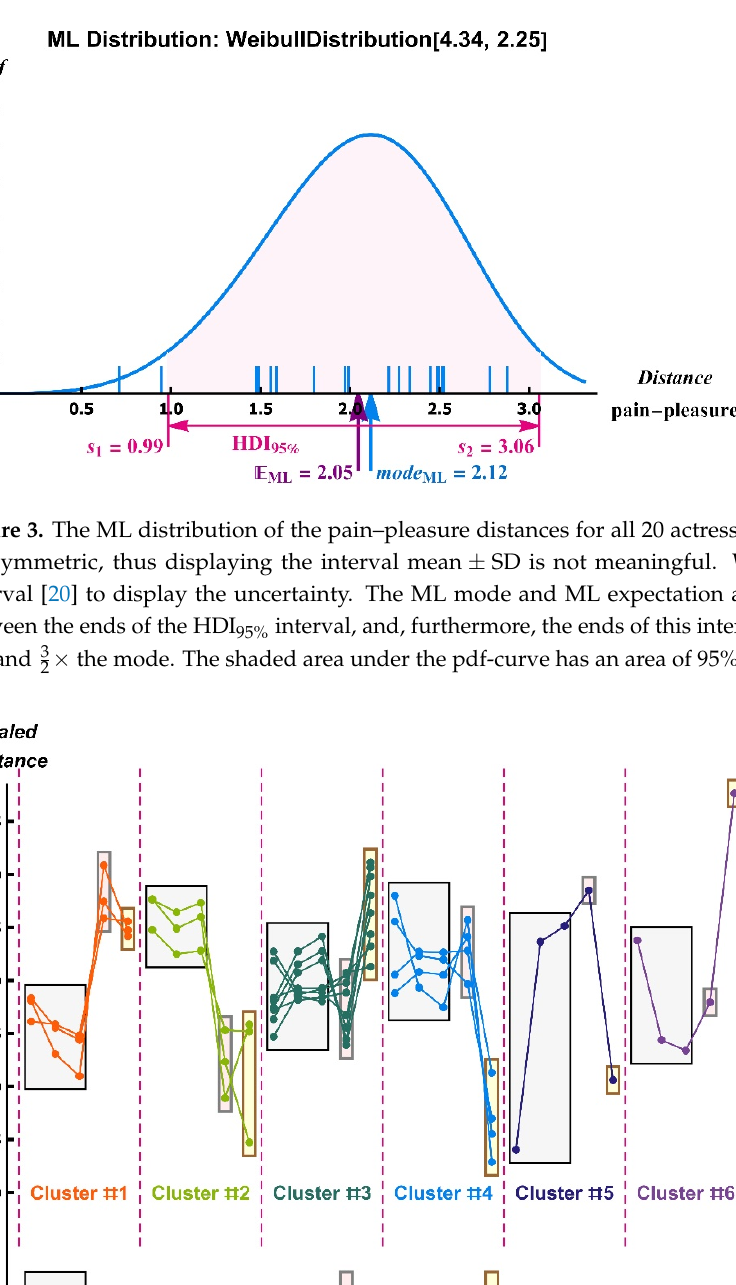
Figure 4. The clusters detected in the scaled, shifted pattern matrix. Distances are scaled by the neutral mean. There are six clusters with membership sizes: 3, 3, 8, and 4, along with two further clusters containing singletons (isolates). We observed the following: (i) In Cluster #1, the distances of pain and pleasure from the neutral mean are nearly equal and larger than those of the neutrals to the neutral mean. (ii) In Cluster #2, the distances of pain and pleasure to the neutral mean are also nearly equal but considerably less than the distances of the neutrals to the neutral mean. (iii) In Cluster #3, there is hardly any overlap between the pain and pleasure distances, and the pain distances overlap the neutral distances to the neutral mean. Additionally, the pleasure distances are larger than the pain distances. (iv) In Cluster #4, the pain distances overlap the neutral distances to the neutral mean, but the pleasure distances do not; the latter are, furthermore, much smaller than the other